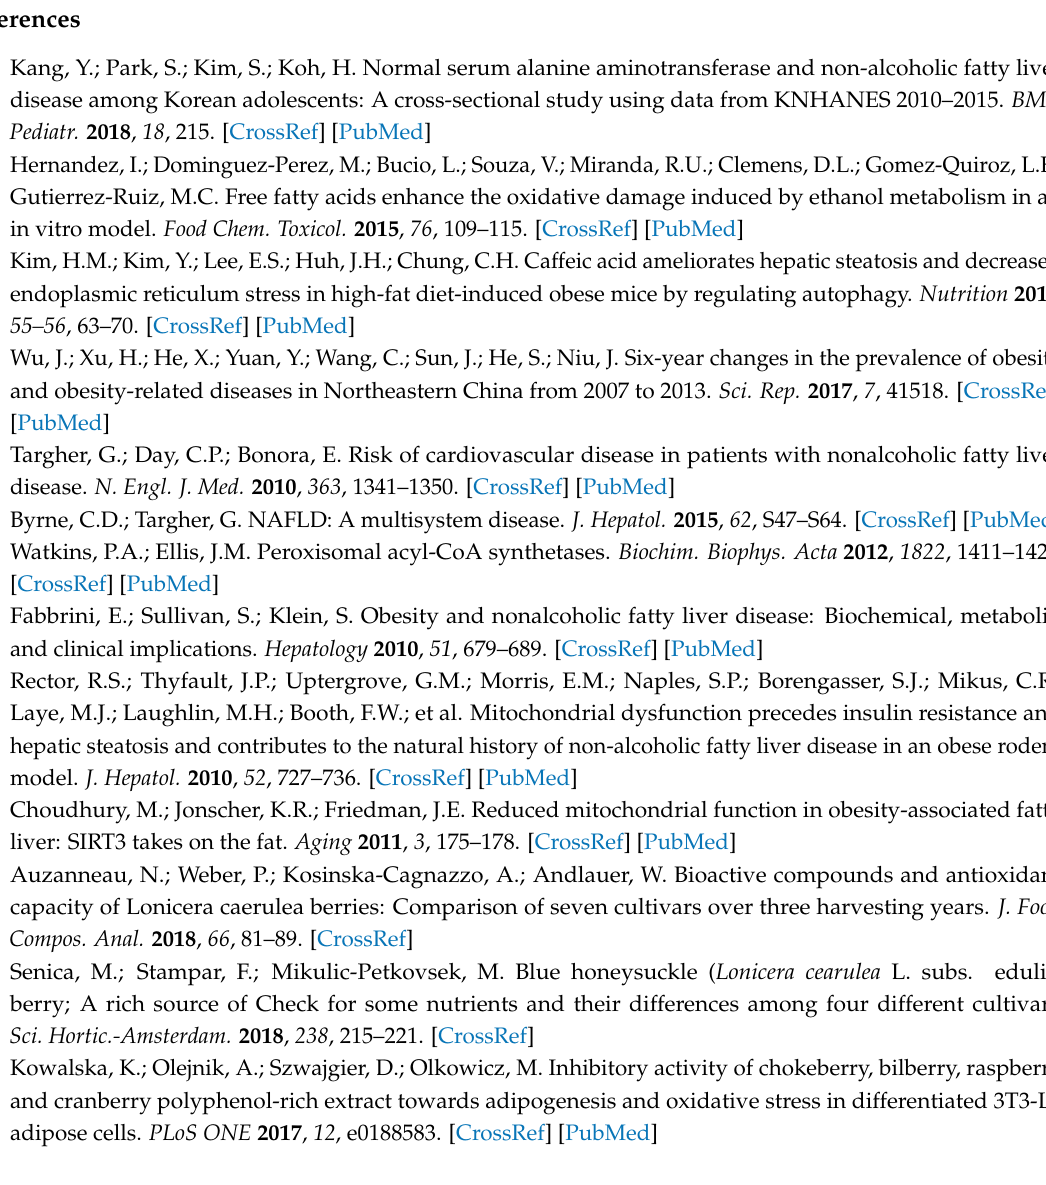
Figure S1: Schematic overview of the experimental design, Table S1: Calculated diet composition of HFD